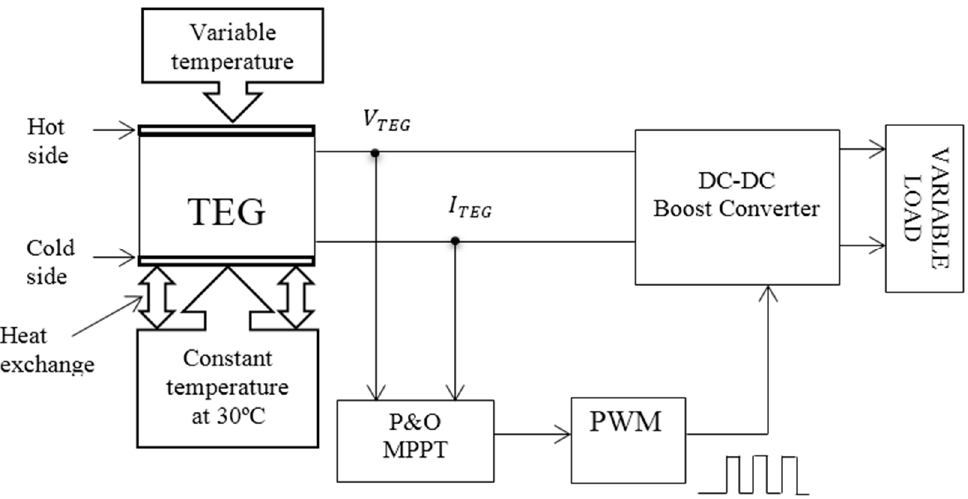
Figure 7. Block diagram of TEG/dc-dc converter system with P&O MPPT.